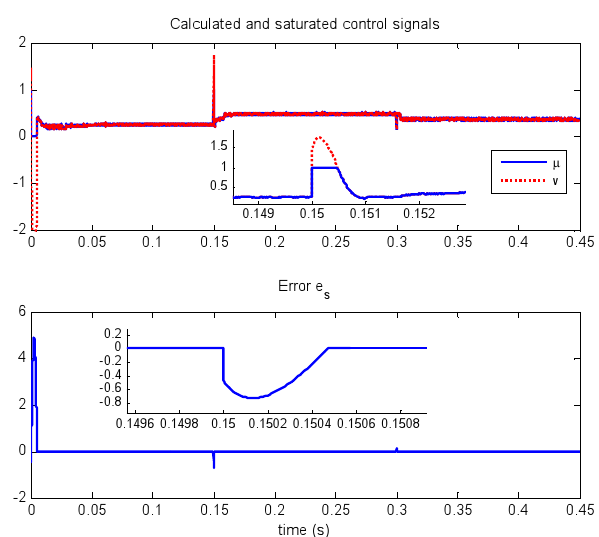
Figure 14. Computed control signal v ( t ) , the applied value µ ( t ) , and the error e s ( t ) in the presence of a time-varying reference.